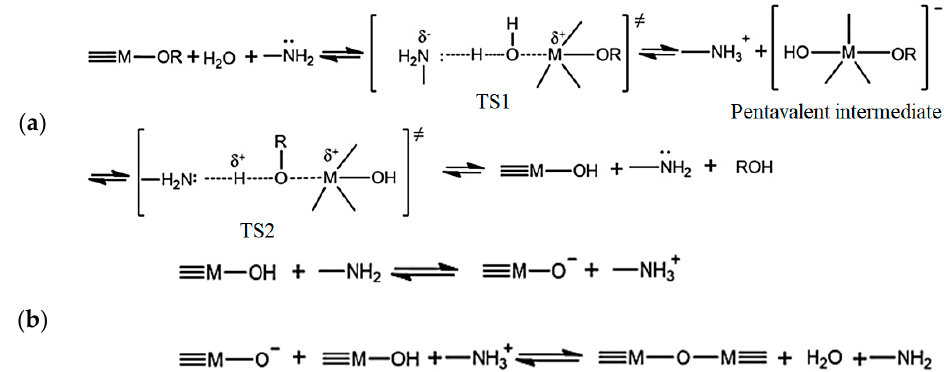
Scheme 8. Hydrolysis ( a ) and Condensation ( b ) mechanism of the sol-gel reaction (M = Si or Ti)